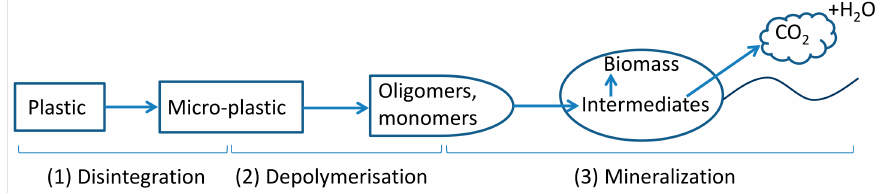
Figure 1. Plastic biodegradation under aerobic conditions. Arrows represent carbon